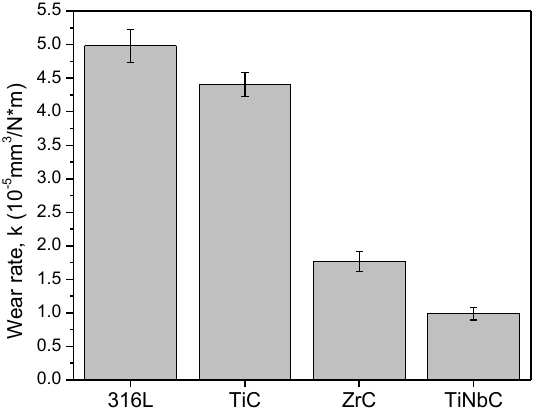
Figure 8. Wear rate ( k ) of the coated and uncoated substrates at the end of tribological test in 0.9% NaCl at 37 ± 0.5 °C (values were calculated by determining the cross-sectional areas of the wear scar at 5 points on each wear track).